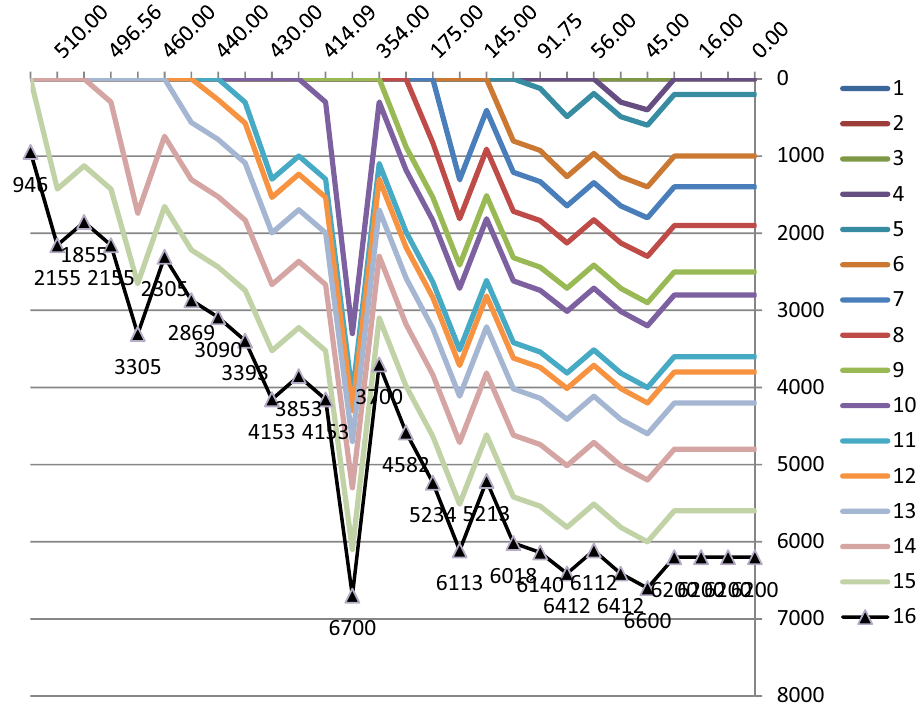
Fig. 7 Curve chart of burial history for strata 3 without skeleton thickness considering max depth